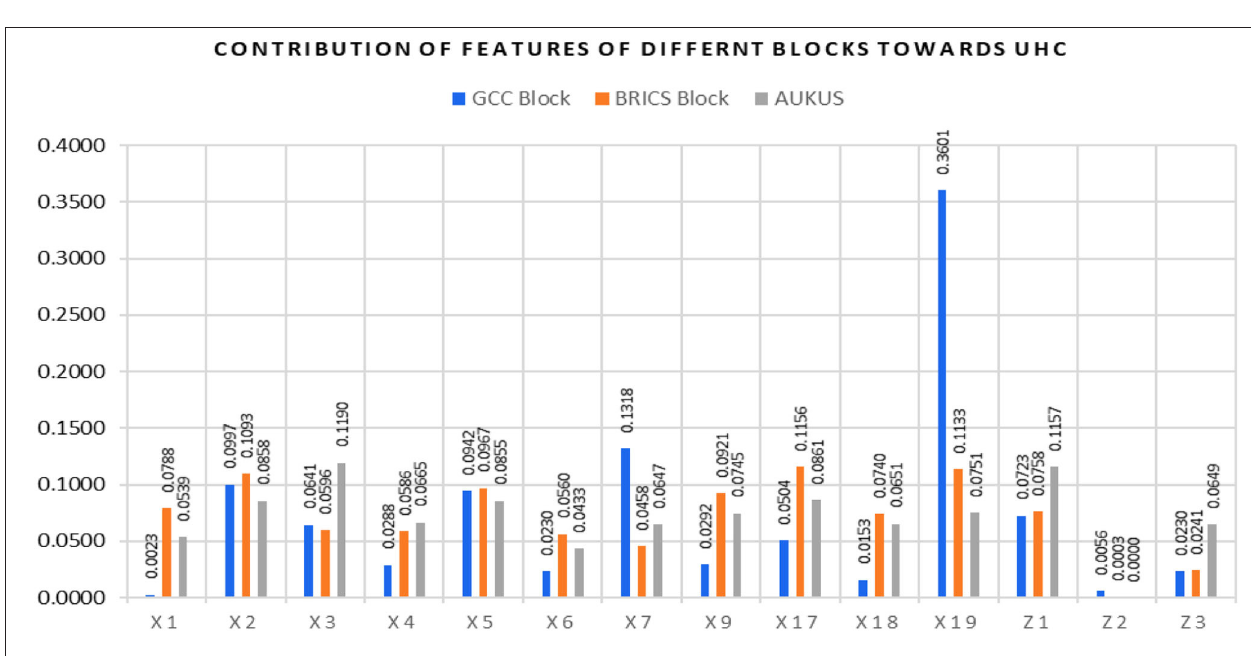
FIGURE 6 | Contribution of the features for UHC in each